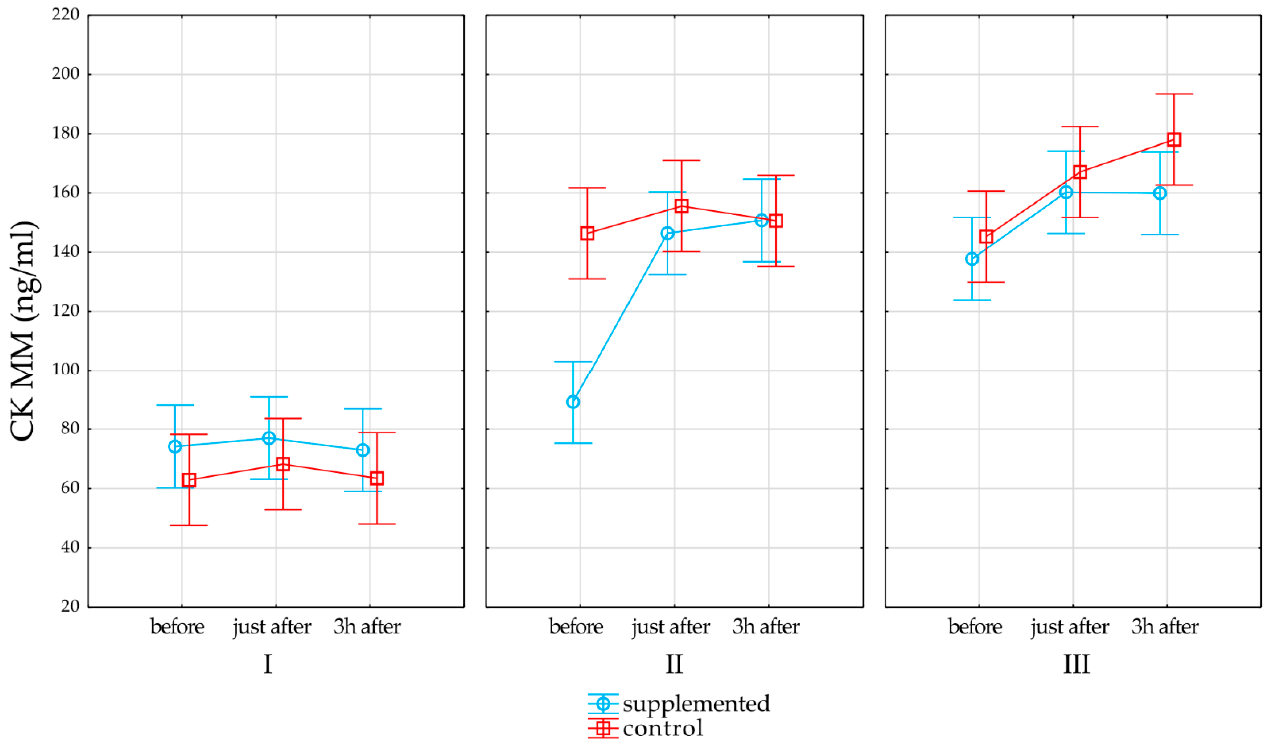
Figure 4. Effects of supplementation on CK MM. Red line denotes changes in the control group, and light blue line denotes changes in the supplemented group. Whiskers denotes standard error, while open rectangles for the control group and open circles for the supplemented group denote mean value.